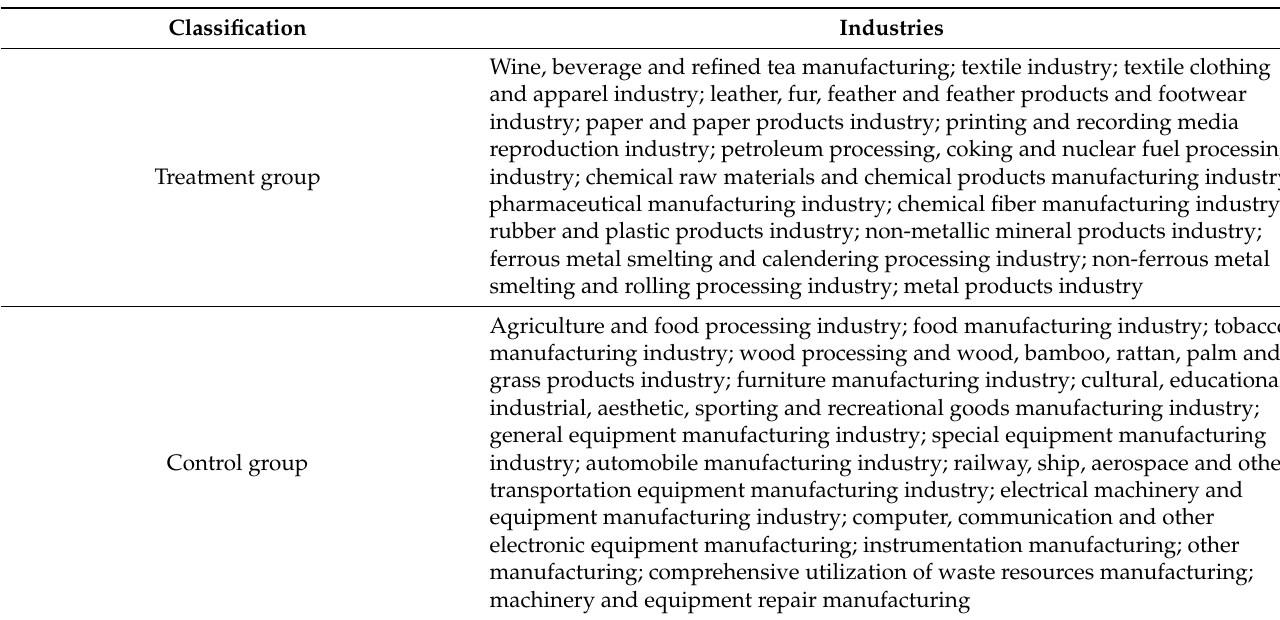
Table A1. Industry Classification of Treatment and Control